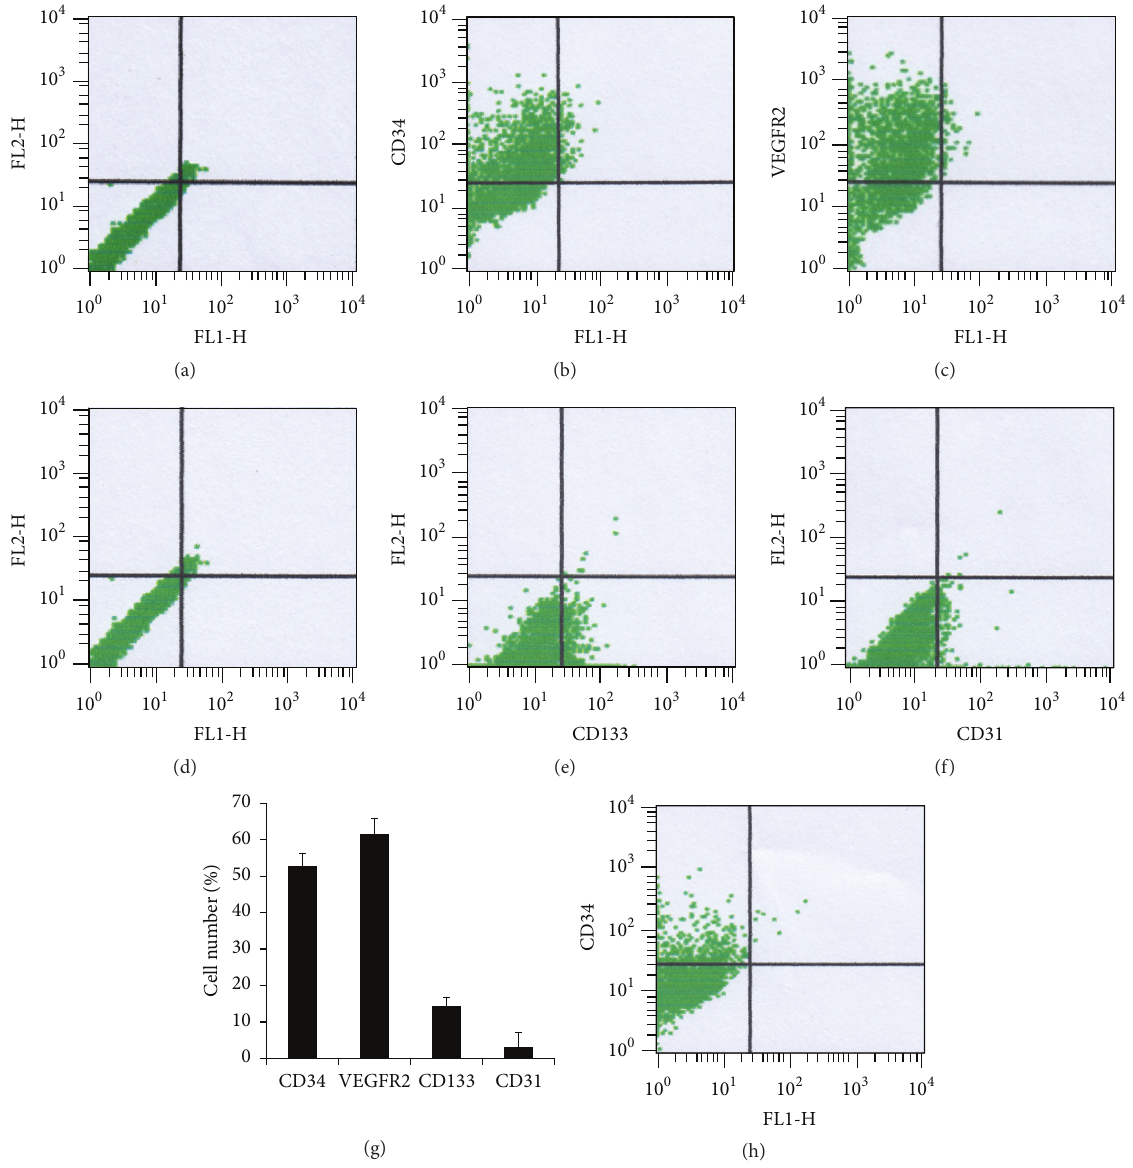
Figure 3: In FACS analyses, EPCs cultured for 15 days were positive for CD34 ((b), 52.73%), VEGFR2 ((c), 61.63%), CD133 ((e), 14.28%), and the mature endothelial-specific marker CD31 ((f), 3.26%). Isotype controls were used in the FACS analyses ((a), (d)). A bar graph (g) showed that the positive rate of CD34, VEGFR2, CD133, and CD31. After being cultured for 30 days, the EPCs were positive for CD34 ((h),